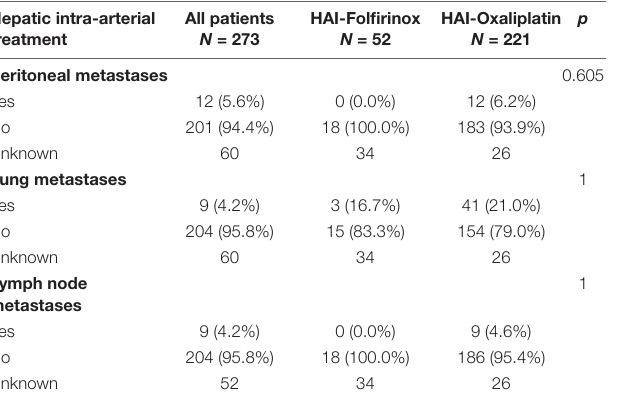
TABLE 1 | Characteristics of the extra-hepatic disease in the